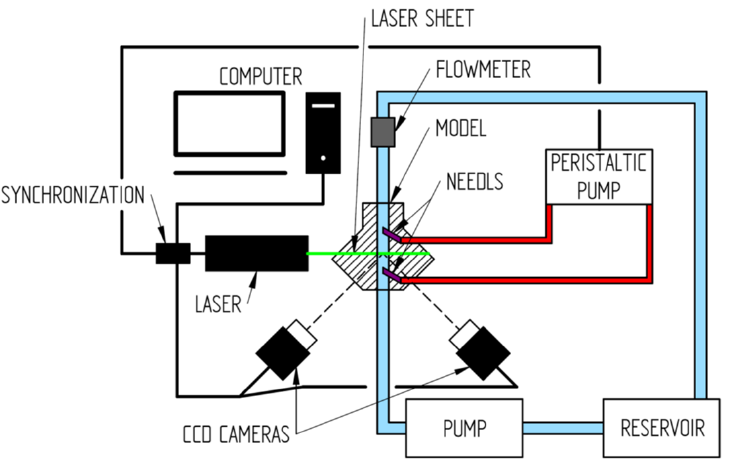
Figure 2. Schematic of experiment. The experimental setup has two circuits. The first circuit (blue) presents part of the vascular system with vascular access for hemodialysis. The second circuit (red) presents an extracorporeal circuit of hemodialysis. Two different pumps were used in this circuit; the first one was the peristaltic pump and the second one was the continual pump. In this experiment, the stereo PIV method, with two CCD cameras, was used for the measurement of flow in the area of the hemodialysis access.